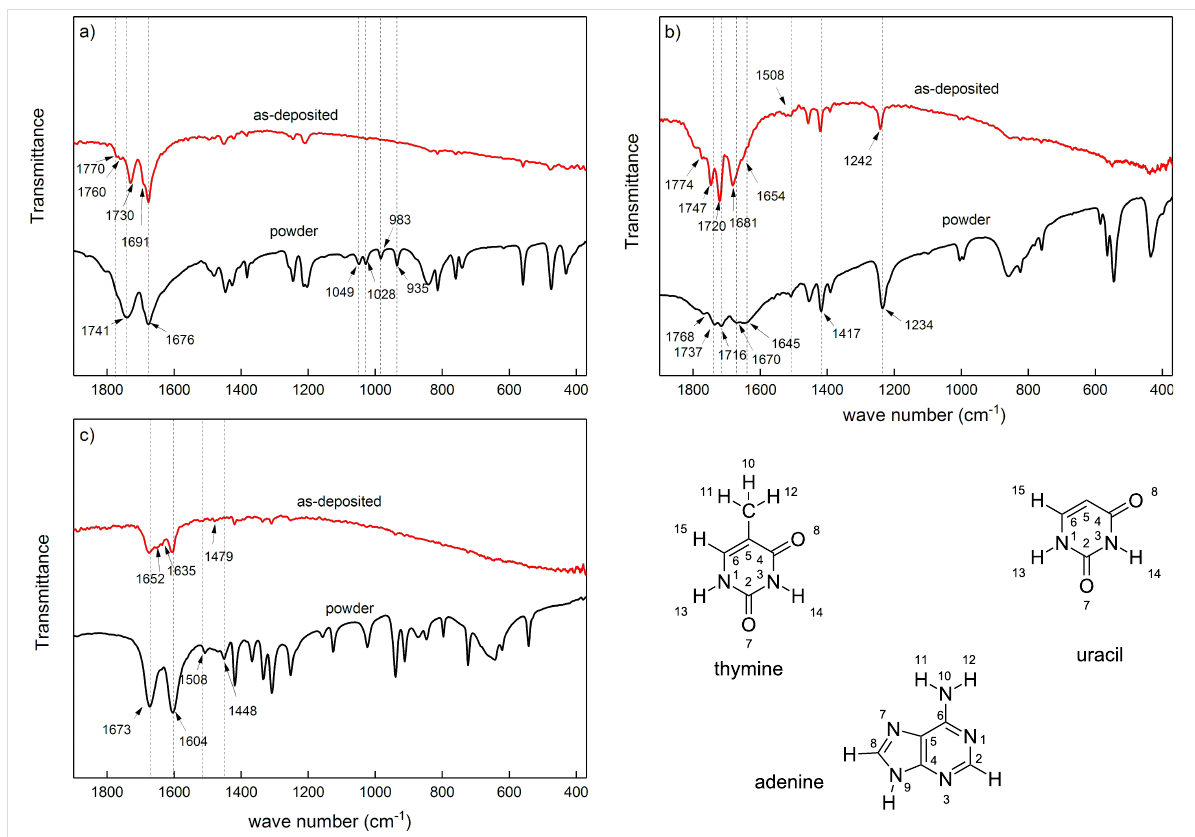
Figure 15: FTIR spectra of powder form and hybrid films of TTIP and (a) thymine (225 °C, 114 nm) (b) uracil (225 °C, 122 nm) and (c) adenine (225 °C, 69 nm).